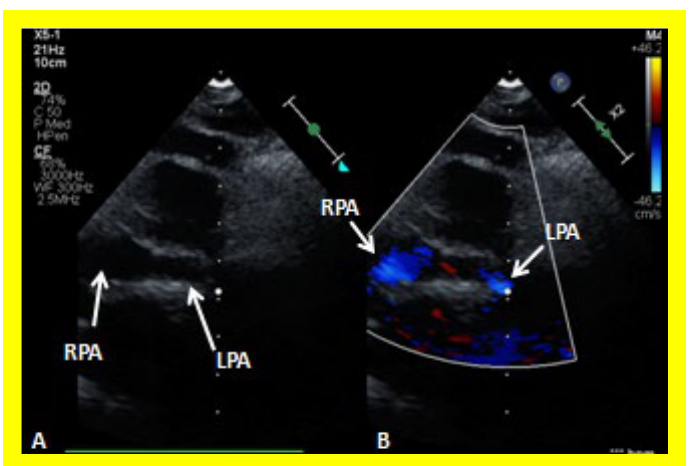
Figure 28. Selected video frames from suprasternal notch view demonstrating right (RPA) and left (LPA) pulmonary arteries without ( A ) and with ( B ) color flow imaging.